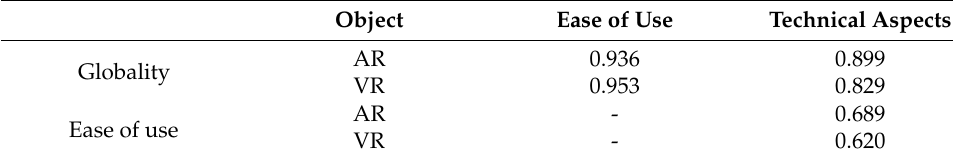
Table 10. Pearson’s correlation coefficient. Source: developed by the authors. Object Ease of